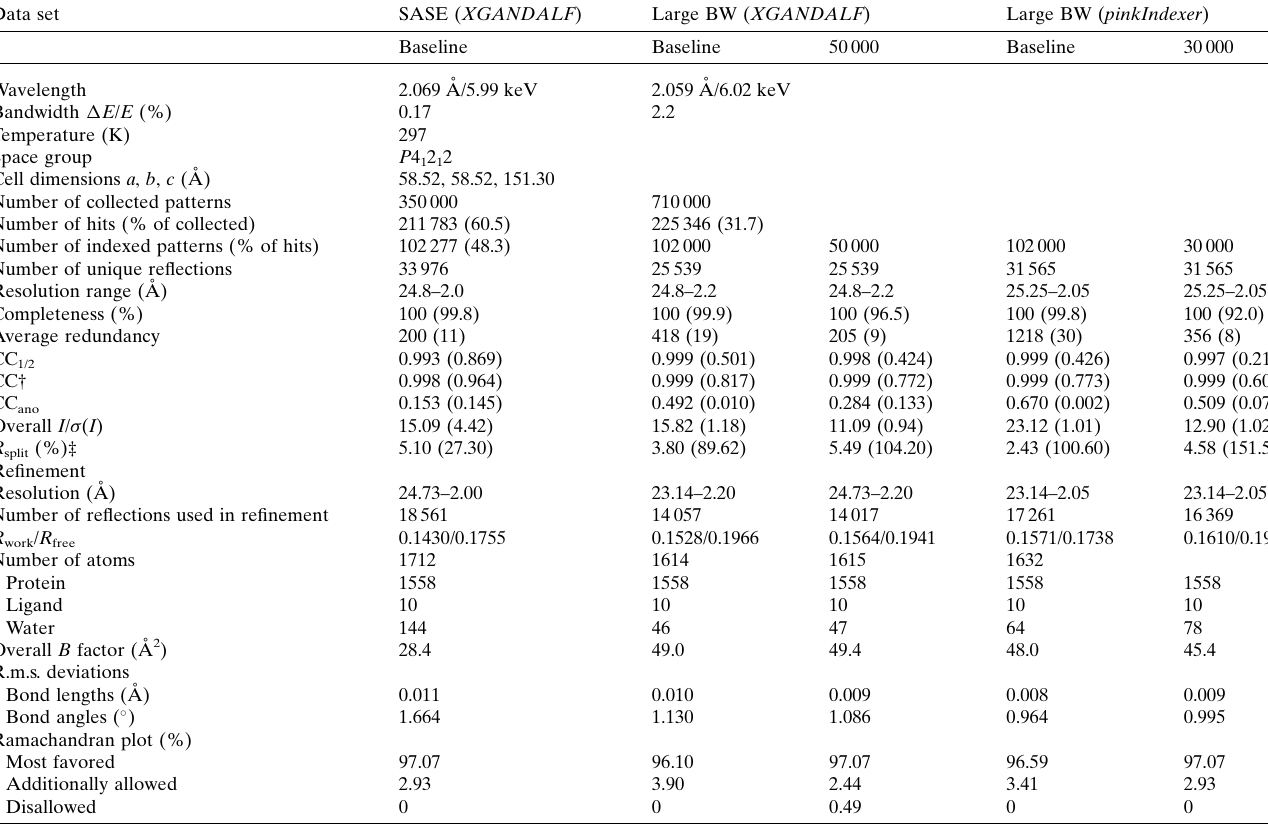
Table 1 SFX data-collection and refinement statistics. Data